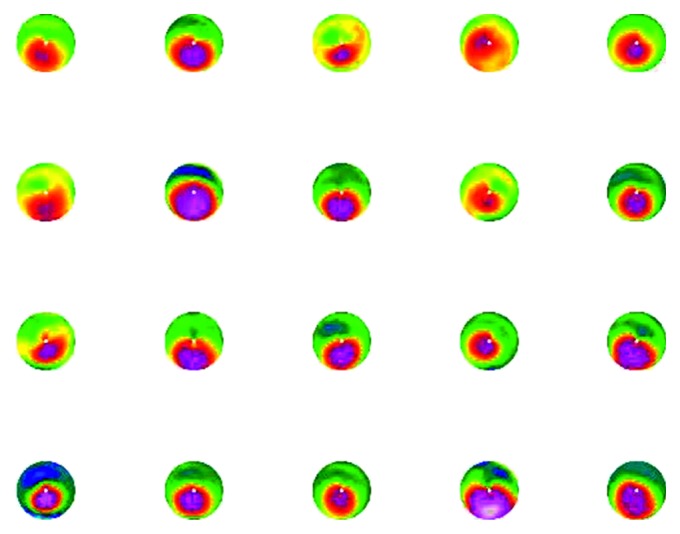
Algorithm input.